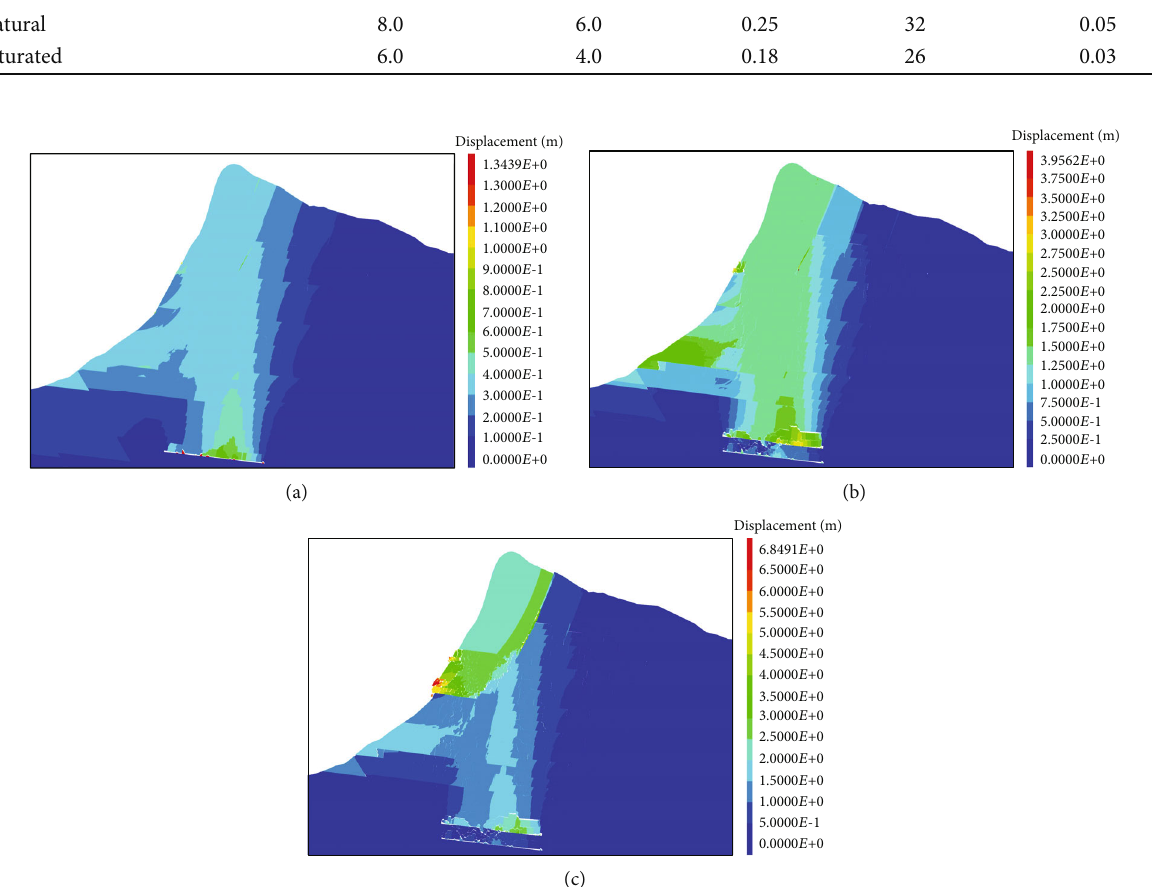
Figure 7: Displacement cloud map of mining slope: (a) No. 14 coal seam mined; (b) No. 10 coal seam mined; (c) after heavy